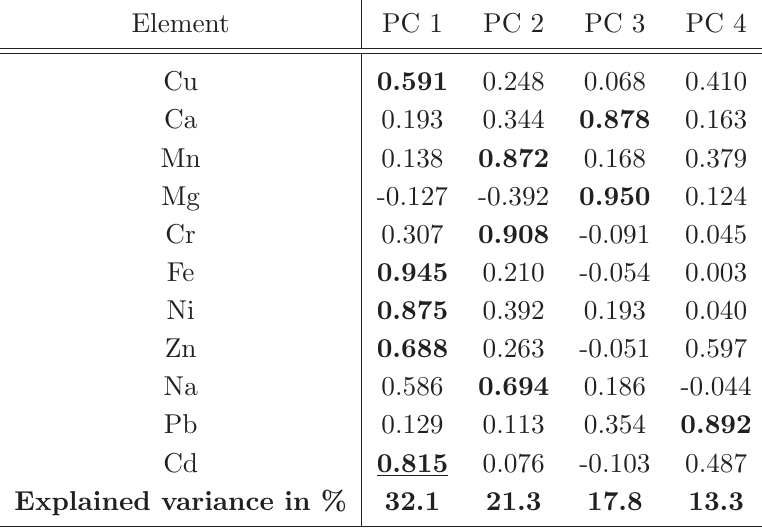
Table 1 Factor loadings (the highest loadings are